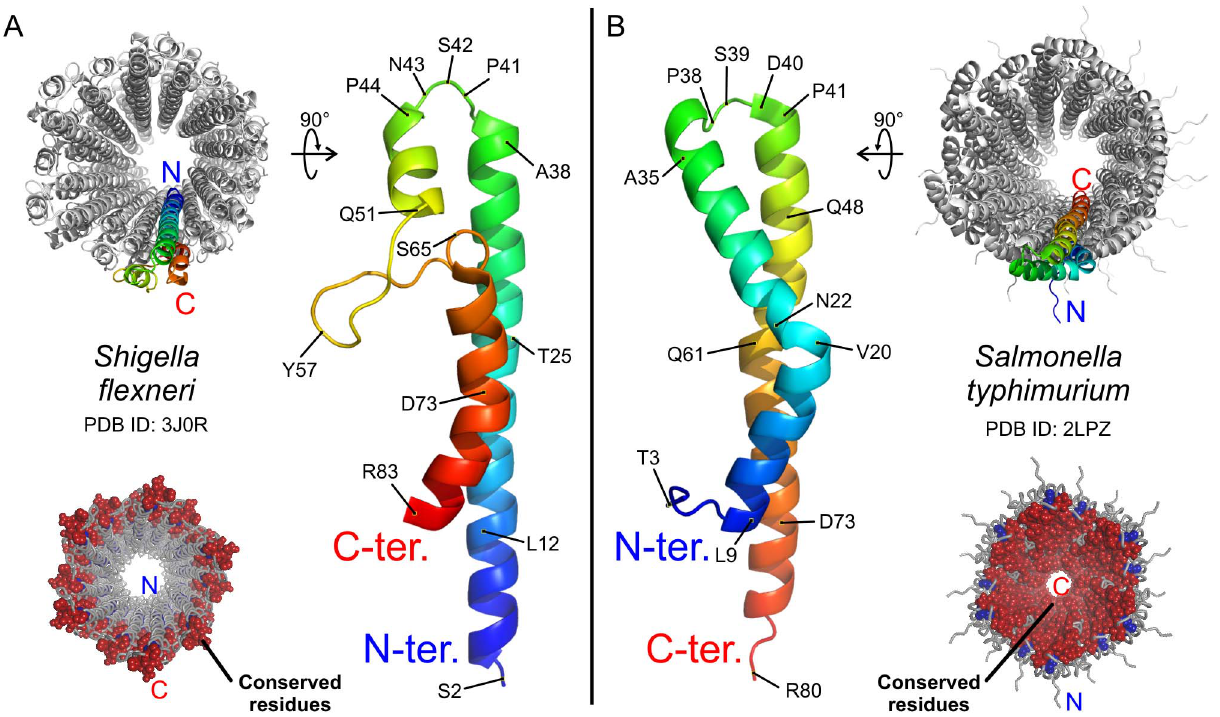
Figure 1. Proposed topologies for T3SS needle proteins in the needle assembly. A , Model of Shigella flexneri T3SS needle based on a 7.7-A˚ cryoEM map, according to Ref. [19], PDB ID: 3J0R. The structure of the MxiH subunit protein contains an a -helix (S2-A38), a loop (K39-P44), an a -helix (Q45-Y50), a 14-residue-long b -hairpin (Q51–Q64) and an a -helix (S65-R83) with a kink at D73. The N-terminus faces inward to the lumen of the needle. B , Solid-state NMR atomic model of the Salmonella typhimurium T3SS needle according to Ref. [20], PDB ID: 2LPZ. The structure of the PrgI subunit protein comprises a rigid-extended conformation (T3-Y8), an a -helix (L9-A35) with a kink at N22, a loop (A36-P41), and an a -helix (A42-R80). The N-terminus is located at the surface of the needle. Top views of the needle assemblies are shown in the top corners. The structures in the bottom corners present the location of highly conserved residues that were identified from multiple sequence alignment (Fig. 2). The atoms of conserved amino acids are represented as spheres and are colored respectively blue or red depending if their amino acid belongs to the N- or the C-terminal region. Conserved residues are lining the lumen of the needle in the Salmonella model but are exposed to the extracellular milieu in the Shigella